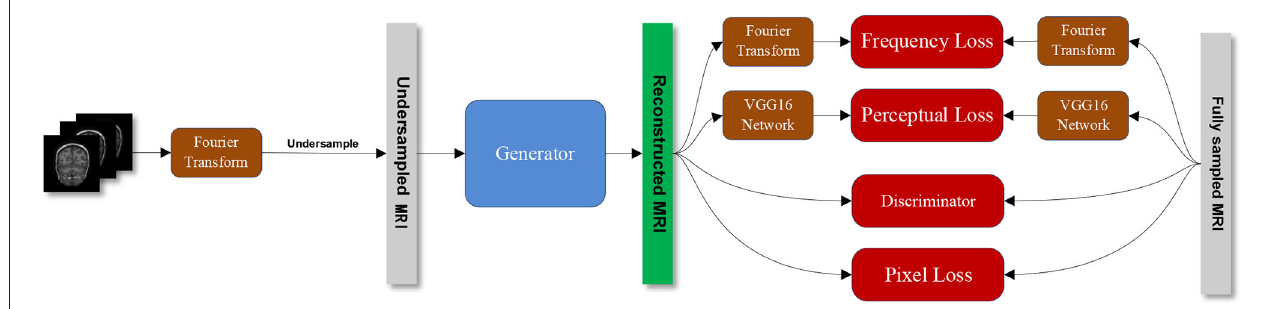
FIGURE 1 | The overall structure of the proposed SARA-GAN